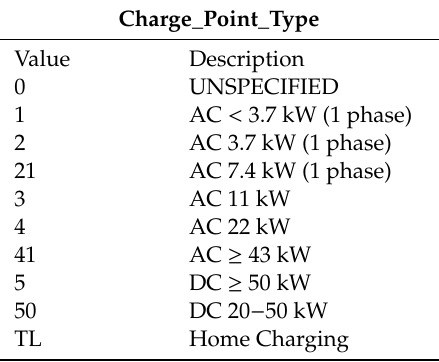
Table 2. Data description of type of charging stations available in the